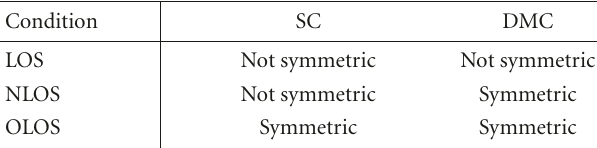
Table 5: Symmetry of the channel in terms of the